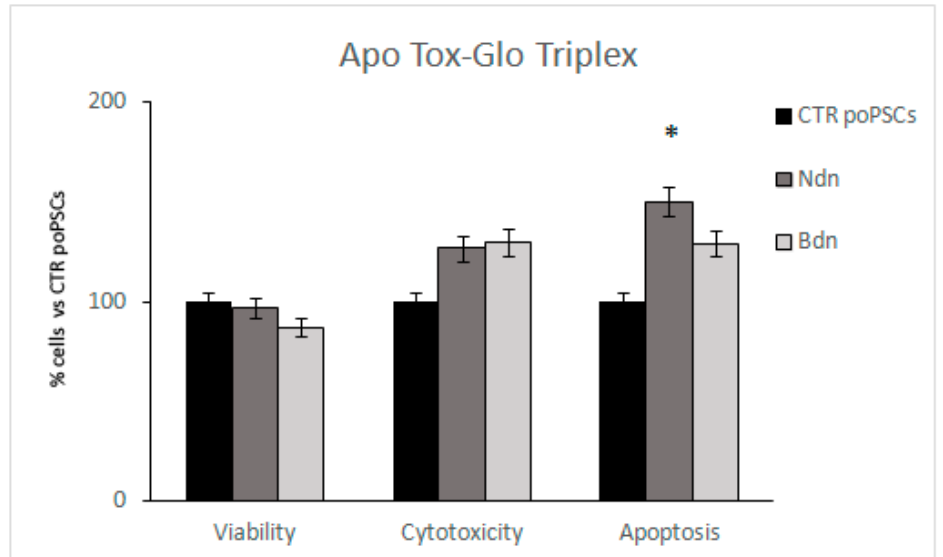
Figure 3. The effect of 14-Day treatment of poPSCs with either 35 µM of nandrolone or 100 µM of boldenone on cellular viability, cytotoxicity, and apoptotic cell death (estimated by ApoTox-Glo Triplex Assay). Results were expressed as percentages with the poPSCs control values (CTR) taken as 100%. The results represent the mean with n = 5 ± standard deviation (SD). Statistical analysis: homogeneity of variance—Levene’s test, normality of distribution—Shapiro–Wilk test, one-way ANOVA, Tukey’s post-hoc test, * p < 0.05.